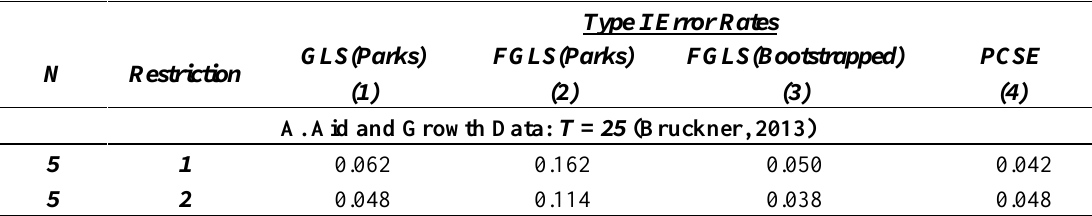
Table 3 : Robustness check: Further analysis with two additional